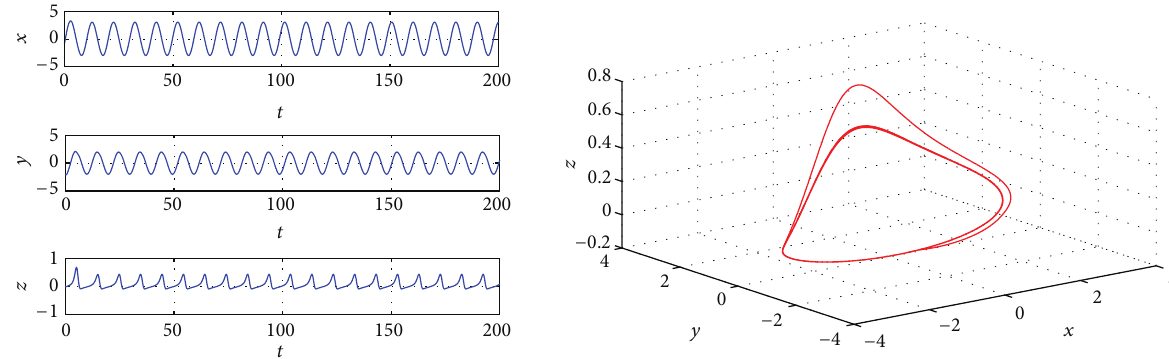
Figure 4: The trajectories and phase graphs of system (61) with 𝜏 = 1.3497 when 𝐾 = −1